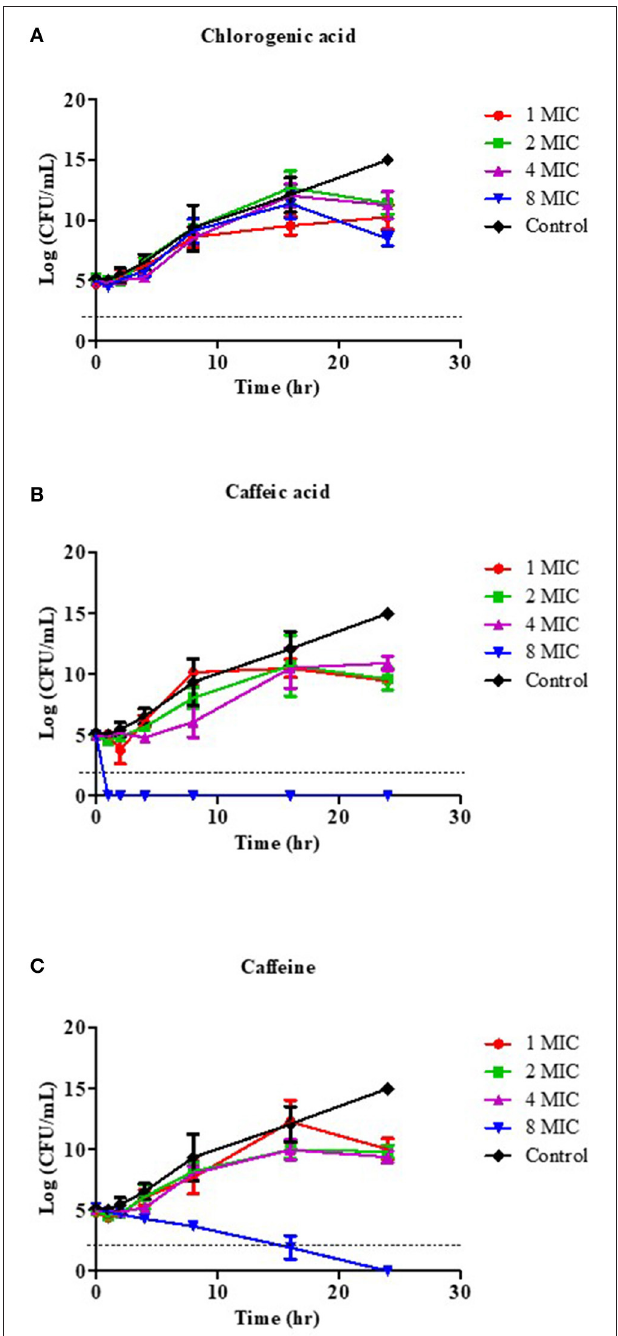
FIGURE 1 | Effect of coffee phytochemical on the viability of V. cholerae O1 El Tor N16961. Time-kill kinetics of CGA (A) , CA (B) , and caffeine (C) at concentrations of 1–8 MIC against V. cholerae were investigated over a 24h incubation period at 37 ◦ C. The MIC for CGA was 0.5 mg/mL, while the MICs for CA and caffeine were 1 mg/mL. MHB was used as the control instead of compound. Samples were taken at 1, 2, 4, 8, 16, and 24h to determine viable bacterial numbers. The bactericidal level is indicated by the dashed